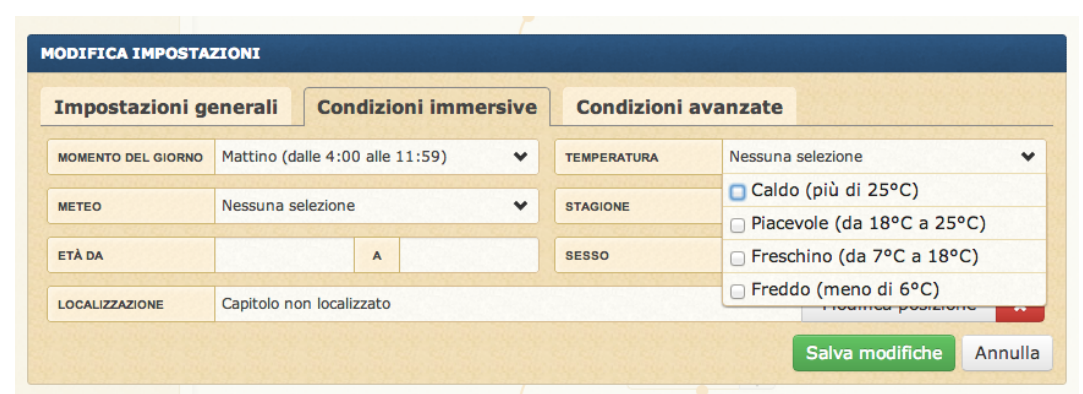
Figure 6. Inbooki chapter